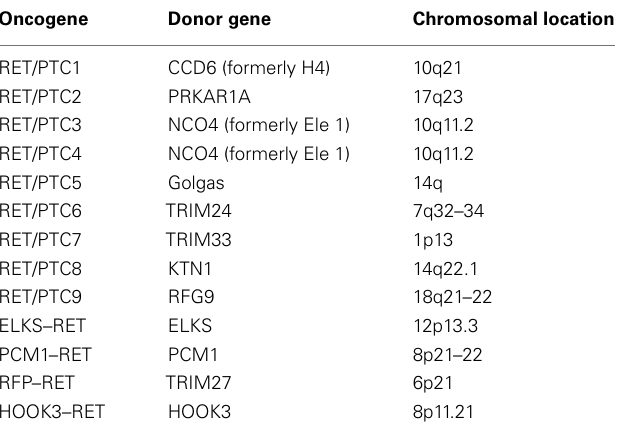
Table 2 | Different types of RET/PTC rearrangements in thyroid